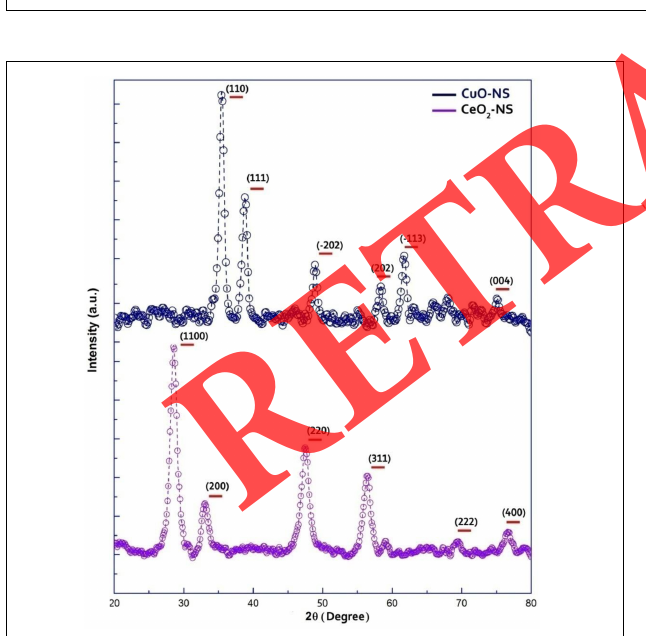
FIGURE 5 | XRD analysis of prepared CuO-NS and CeO 2 -NS.